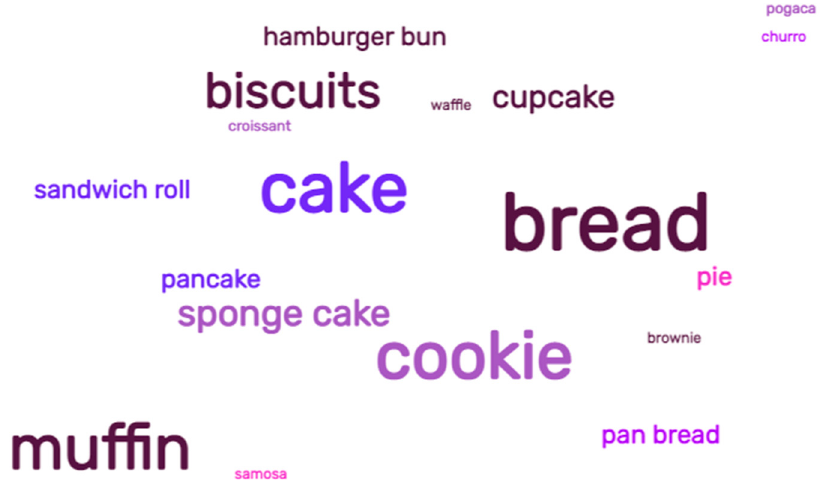
Figure 4. Word cloud for the products analyzed in the different studies.